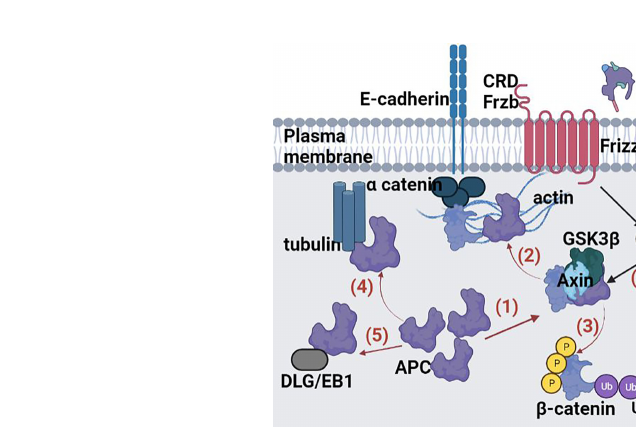
FIGURE 3 | Crosstalk between Notch, Wnt, MAPK and AA signalling pathways. A small increase in cytoplasmic b -catenin levels leads to activation of Wnt gene transcription. The Wnt glycoprotein is synthesized and will be activated by binding to one of the members of the Frizzled family (Frzb) – the Wnt receptor. From the receptor, the signal is transmitted inside the cell to casein kinase II (CKII); it activates and phosphorylates the Disheveled protein (Dsh). The active Disheveled protein is translocated from the cytosol to the cell membrane where, through a signalling process, protein kinase C is phosphorylated, and in turn phosphorylate GSK3 b to a N-terminal Ser residue. The effect is the inhibition of GSK3 b and fi nally the b -catenin accumulation in the cytosol. From the cytosol b -catenin is translocated into the nucleus, independent from Lef/Tcf transcription factors translocation. At this level the protein binds Lef/Tcf architectural transcription factors and Wnt gene transcription is induced. Following the interaction with b -catenin, the transcription factors Lef and Tcf can no longer bind to the corresponding sites in the promoter region of some genes and thus the transcriptional process of those genes can take place. In this way Wnt promotes post-transcriptional stabilization and accumulation of b -catenin in the cytosol. Figure created in